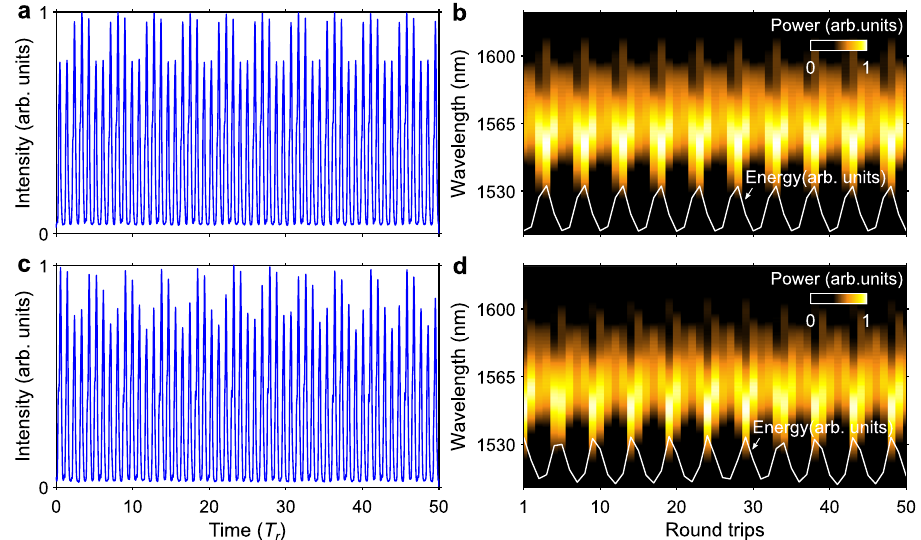
Fig. 2 | Two different breather operations of the laser observed over 50 cavity roundtrips.a , b Frequency-locked breatherstateshowingawell-de fi nedperiodicity, and c , d frequency-unlocked breather state featuring degraded periodicity. Panels